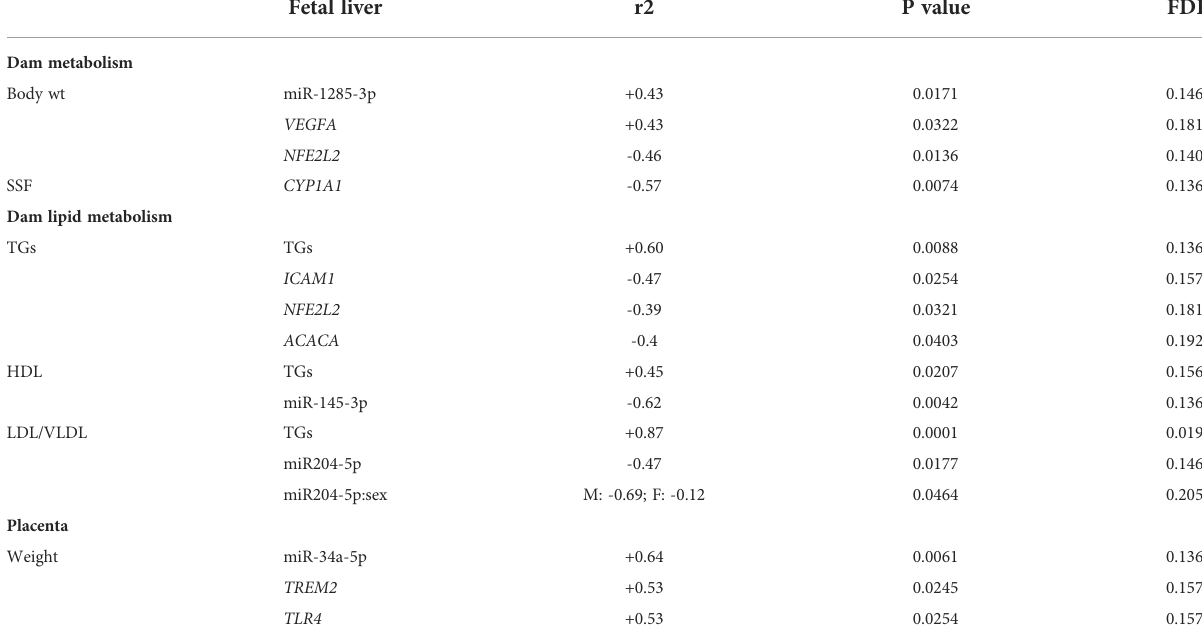
TABLE 2 Associations between maternal and placental characteristics and fetal liver measurements.